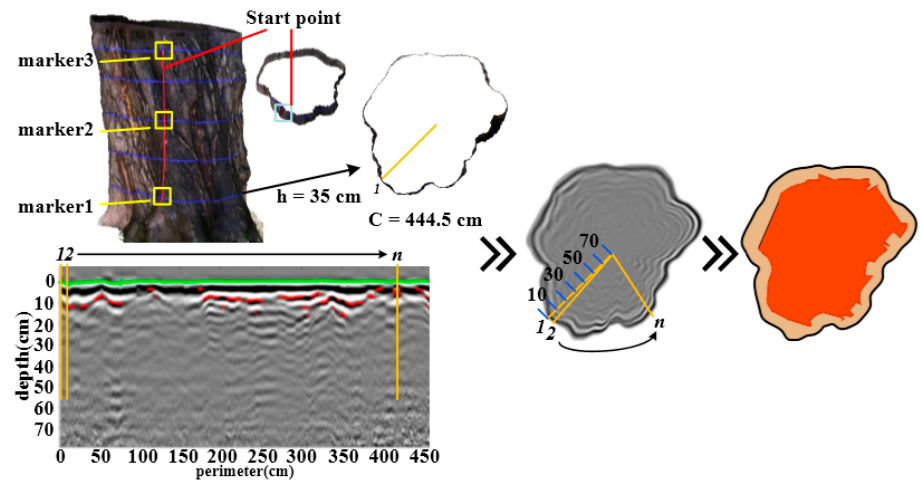
Figure 5. Coordinate mapping of GPR B-Scan.